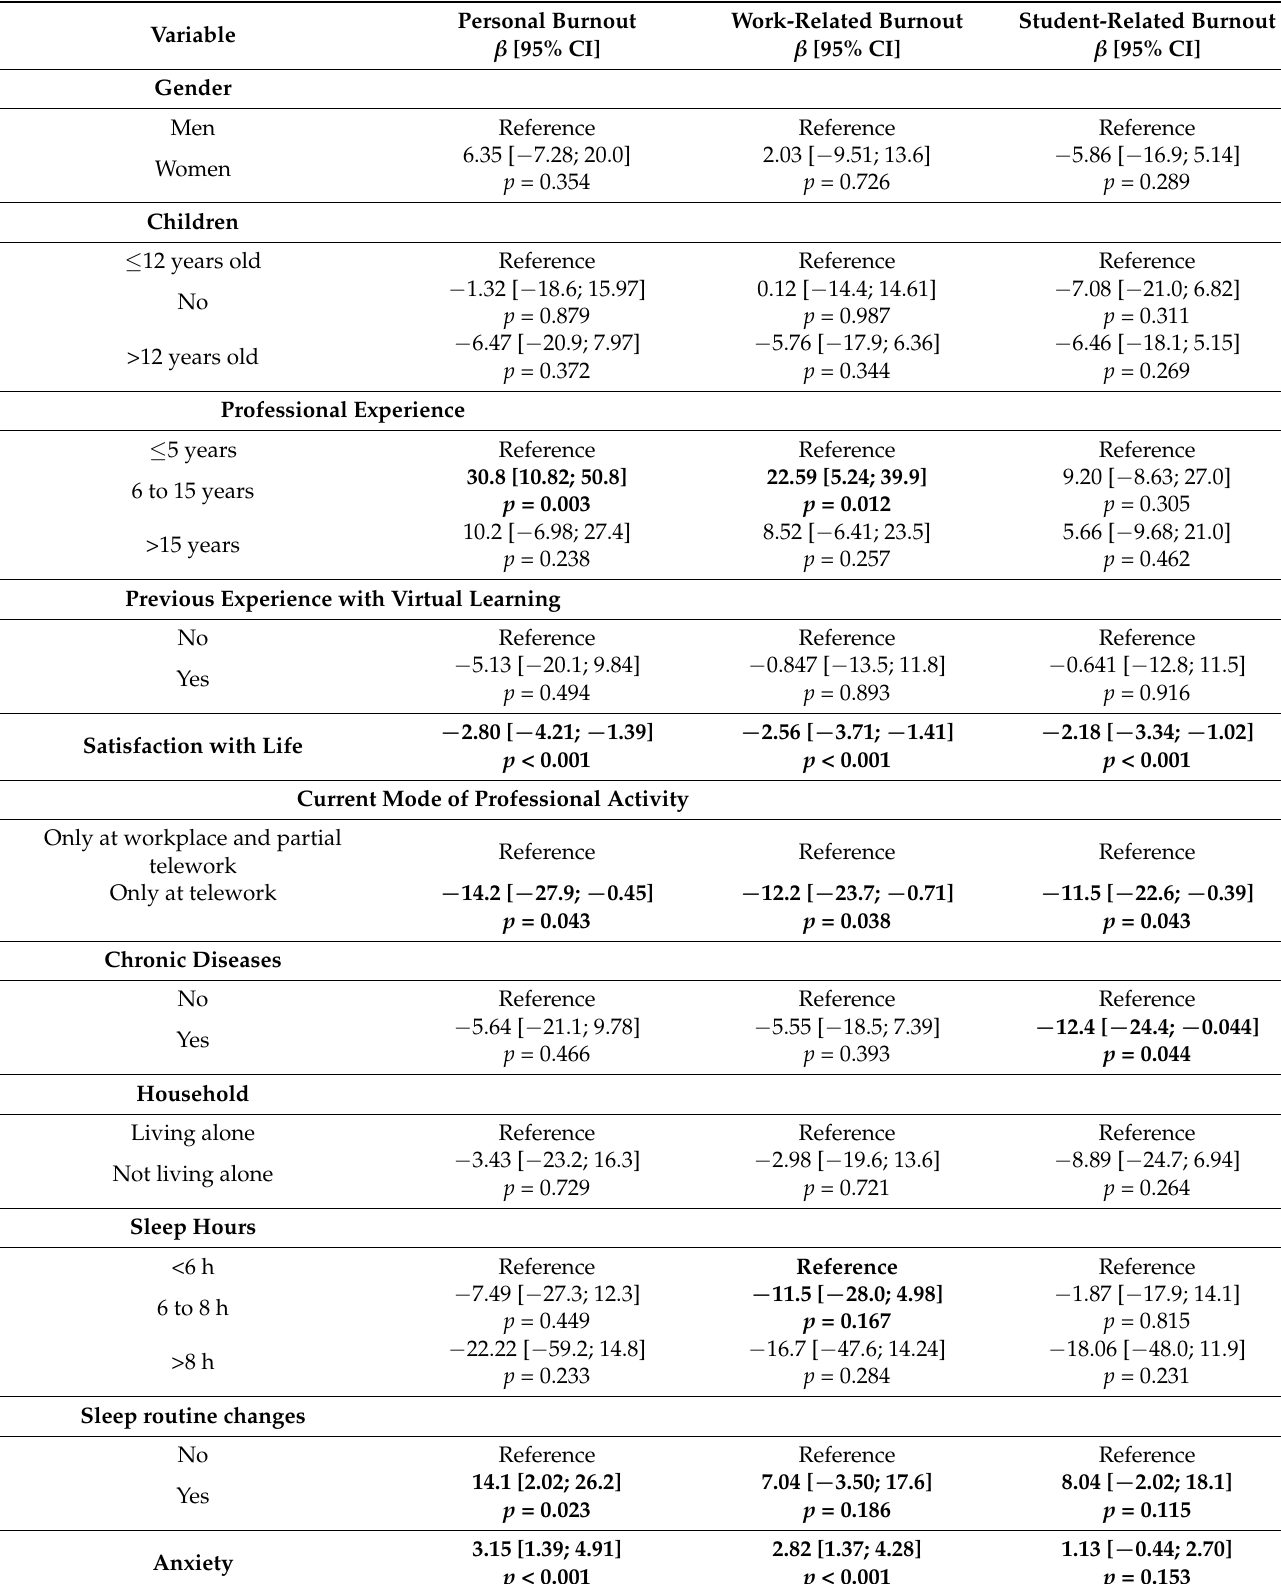
Table 3. Regression unstandardized coefficients ( β ) for CBI dimensions as outcomes and socio-demographic, professional and emotional variables as predictors in simple linear regression analysis